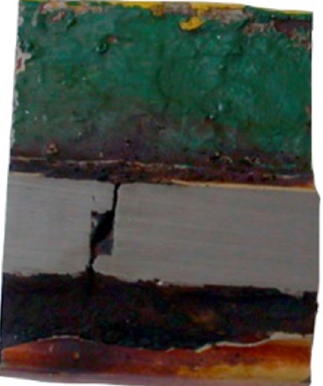
Figure 41. The merging of cracks previously branched at the bolt thread (handy-size bulk carrier 30185 DWT). Macroscopic examination.